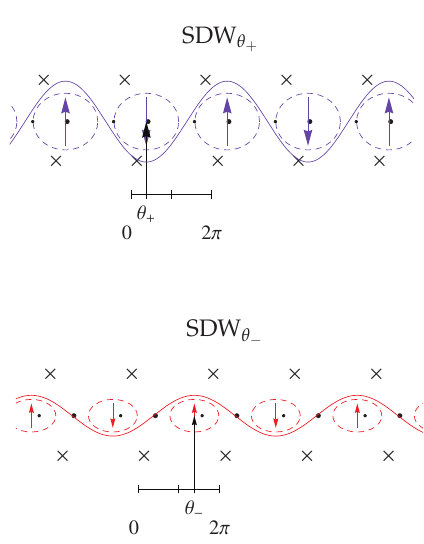
) 2 k F spin-density-wave and their respective phase ( θ −